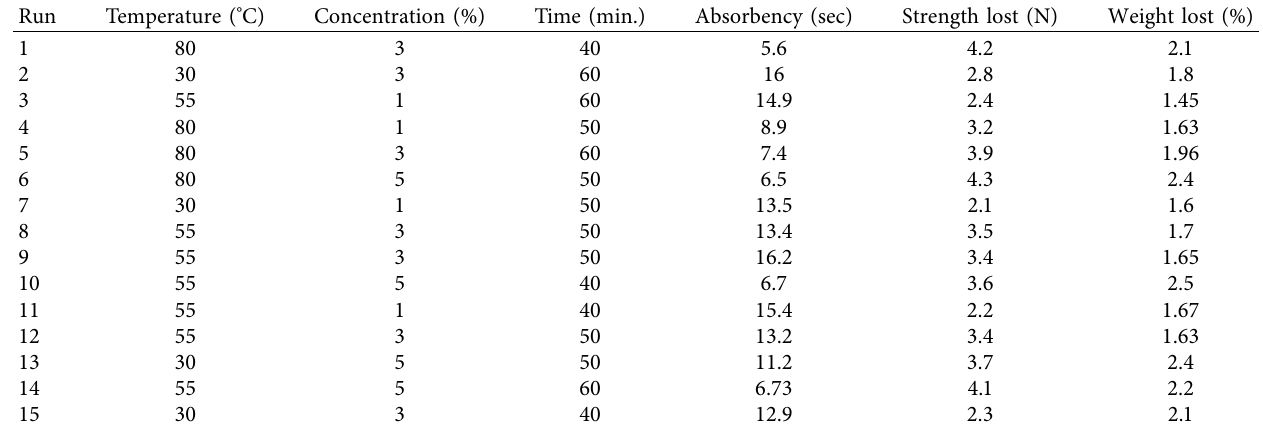
Table 1: The independent variables and their responses using